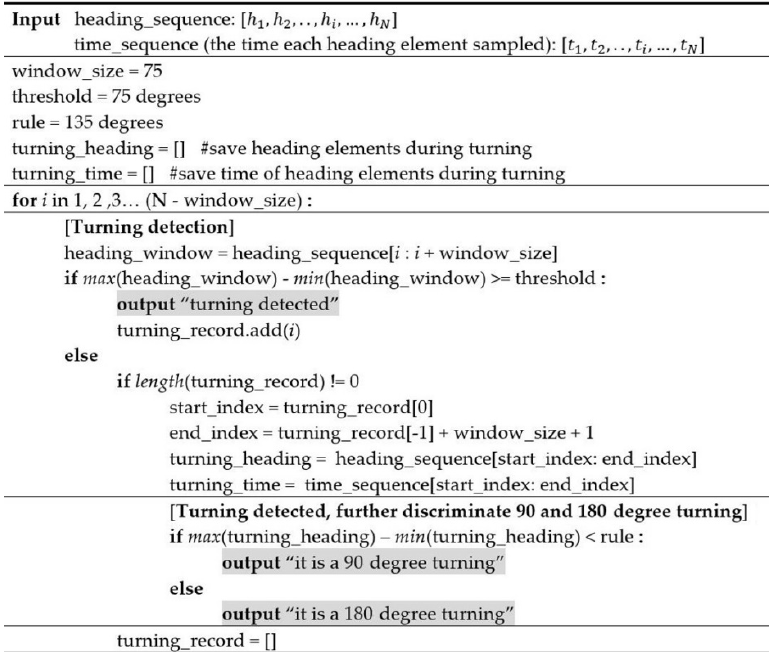
17 of 29 Figure 11. Examples of heading change while performing 90-degree and 180-degree turning. ( a ) Ninety-degree turning examples in C (cid:2869) , ( b ) 90-degree turning examples in C (cid:2870) , and ( c ) 90-degree and 180-degree turning in a 75-element window. Based on our experiment, the average time taken for 90-degree turning is about 1.5 s. There are 75 elements, as the frequency is 50 Hz, so we used a window with size of 75 heading elements to detect turning. To determine the threshold for turning, we need to calculate the minimum heading range of those 138 turnings. We divide those turnings into two categories based on the time cost for turning, (cid:1829) (cid:2869) (turning time less than 1.5 s) and (cid:1829) (cid:2870) (turning time more than 1.5 s). For each turning in (cid:1829) (cid:2869) , we directly calculate its heading range from all heading elements. For each turning in (cid:1829) (cid:2870) , as the number of heading ele- ments is more than 75, we used a 75-element window (moving from, then through, the first heading element one at a time) to calculate the heading range of those chosen heading elements. As there are multiple windows applied for each turning in (cid:1829) (cid:2870) , we calculate the heading range of each window and take the maximum as the heading range of current turning. In this way, we can calculate heading ranges for all turnings in (cid:1829) (cid:2870) . Then, we put the heading ranges of those 138 turns together and find that the minimum heading range is 75 degrees, which is shown by the black dash-dotted horizontal line in Figure 11a,b. Thus, we set 75 degrees as the threshold for our method.